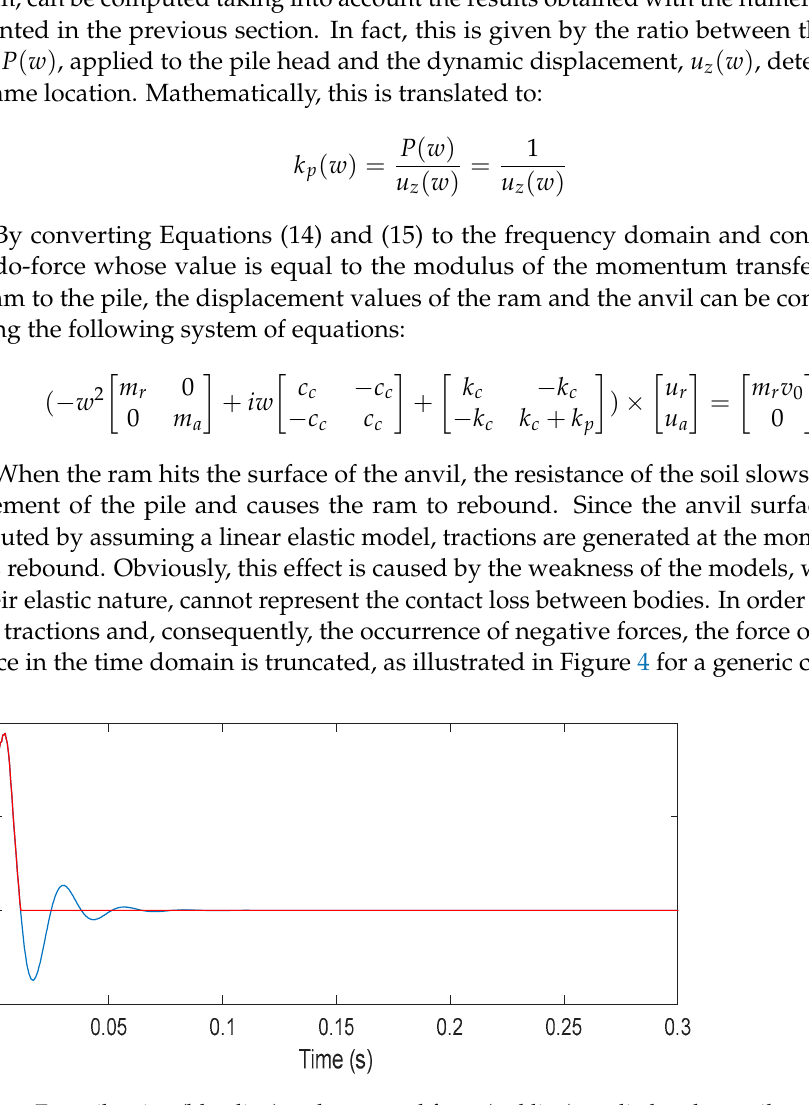
When considering the pile–soil dynamic interaction, the dynamic stiffness of the pile can be comparable to the ratio between the force applied at a point on the pile head and its vertical displacement. This force can be represented as a Dirac delta function, which corresponds to a large force distributed over a small time interval. This dynamic stiffness, responsible for the dynamic coupling between the driving device and the pile–ground system, can be computed taking into account the results obtained with the numerical model presented in the previous section. In fact, this is given by the ratio between the unitary load, P ( w ) , applied to the pile head and the dynamic displacement, u z ( w ) , determined at the same location. Mathematically, this is translated to: